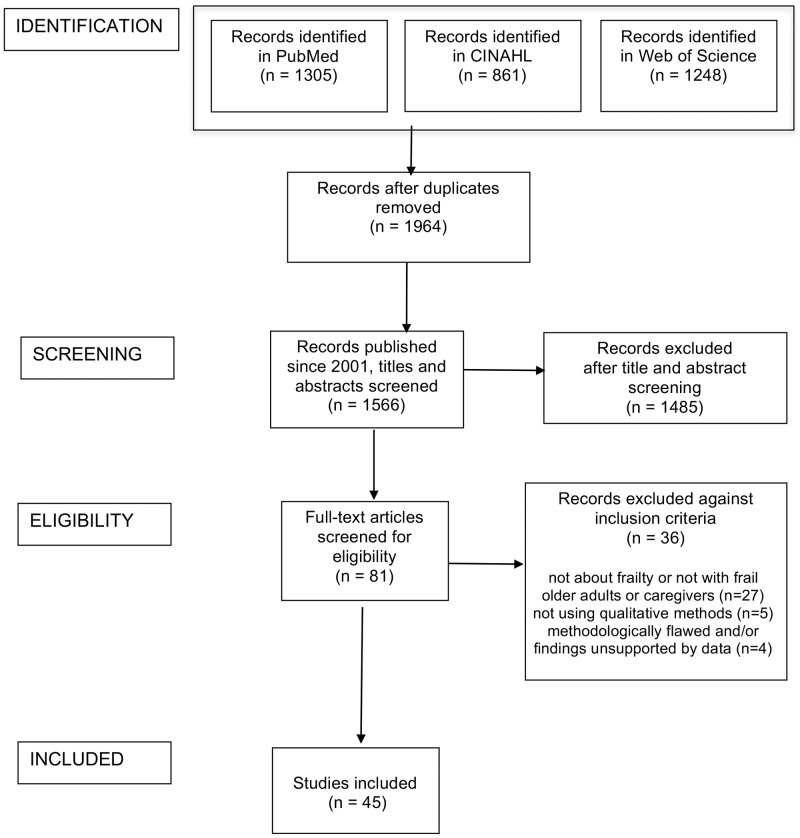
PRISMA flow diagram.